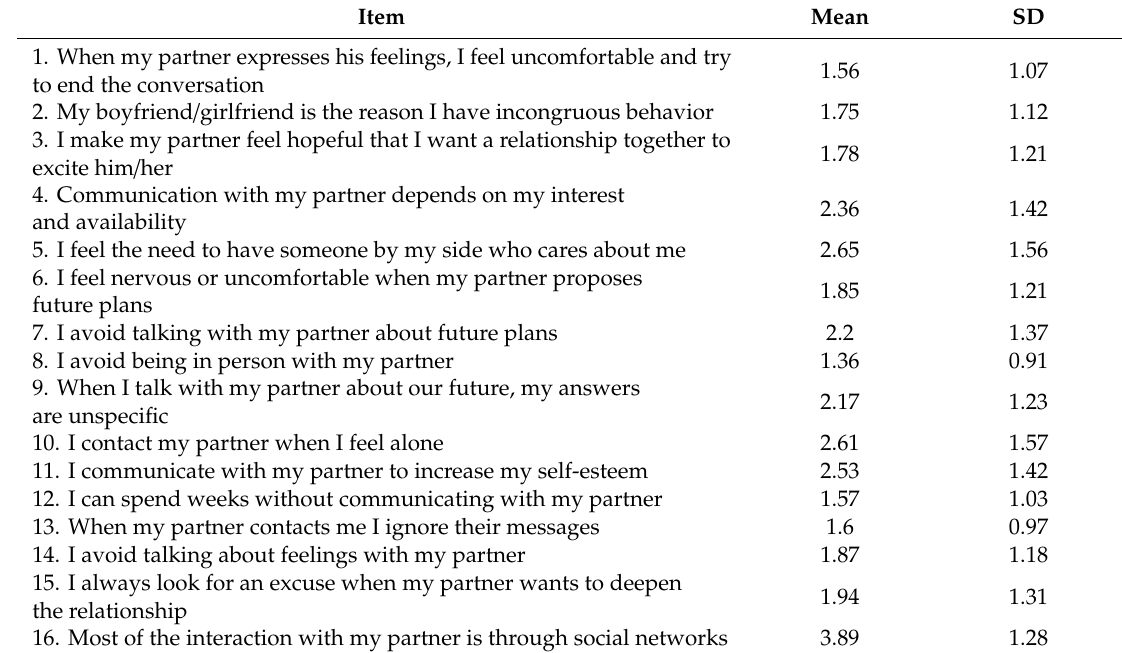
Table 2. Mean and Standard Deviation of each Item.